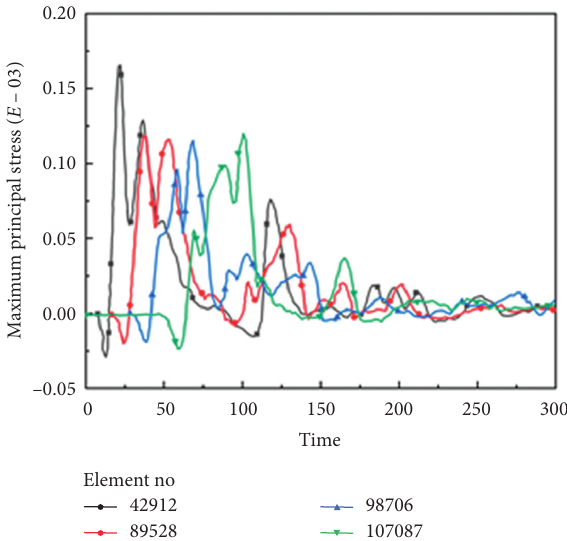
Figure 8: Curve of maximum principal stress-time on selected elements.